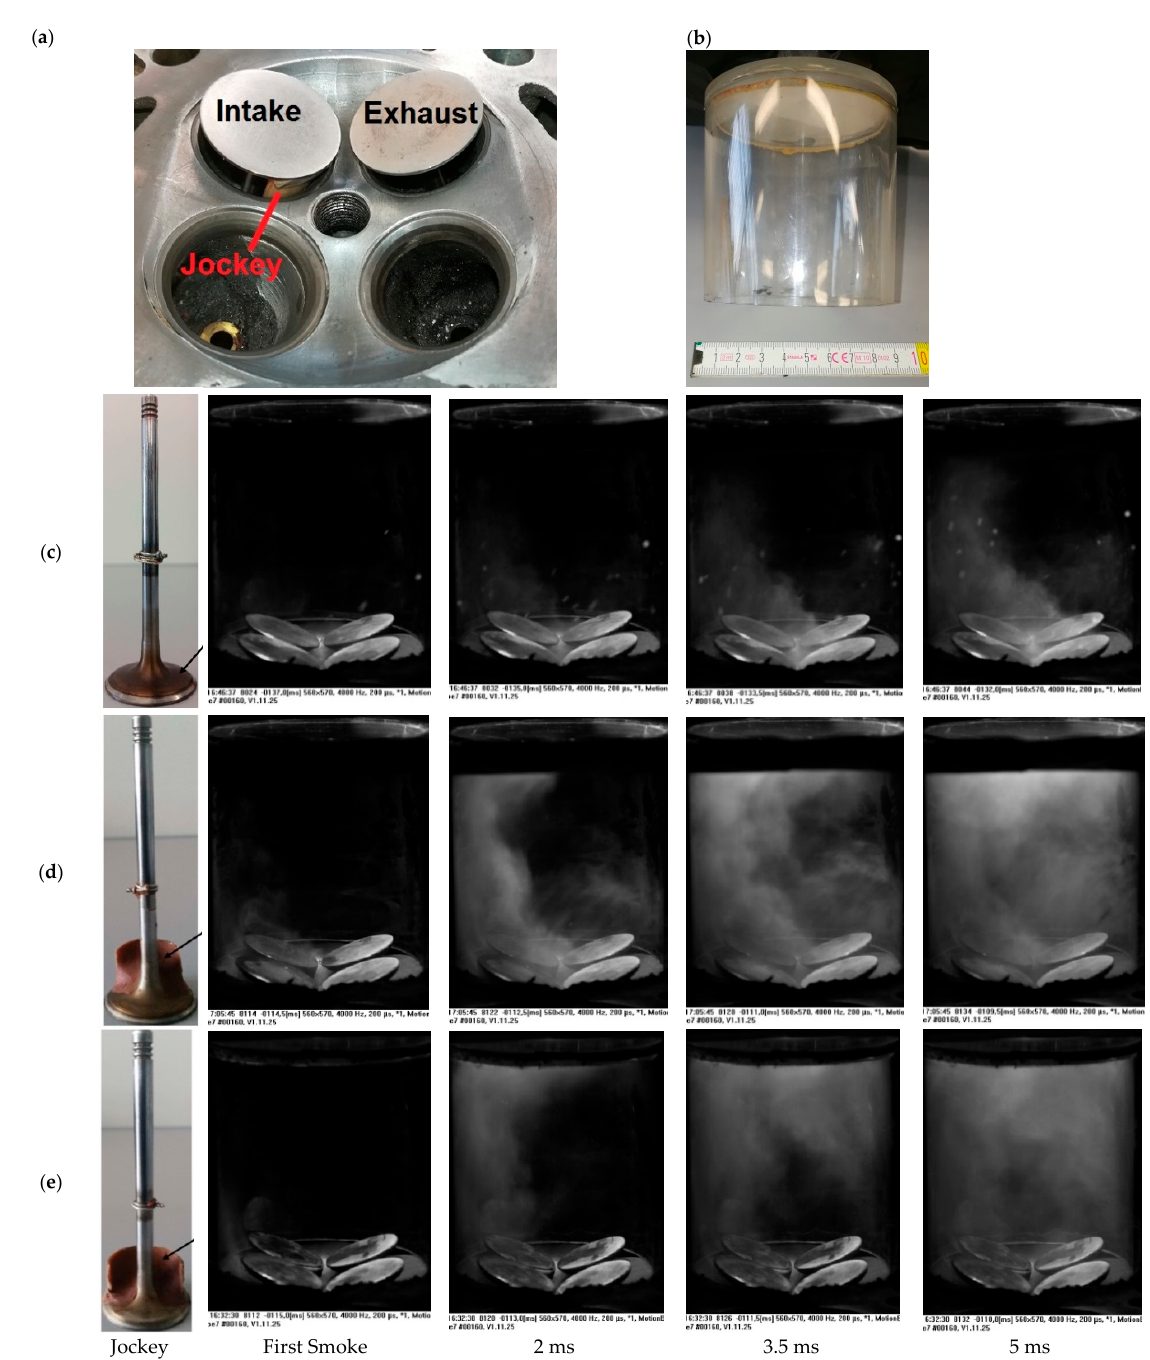
Figure 6. Flow-visualization inside a conventional 500 cm³ 4-valve cylinder (4-stroke gasoline) at 0 ms, 2 ms, 3.5 and 5 ms. ( a ) Cylinder head equipped with one outlet valve and one inlet valve with experimental jockey structure. Characteristic valve stroke is 8 mm. ( b ) Transparent perspex cylinder, scale in cm. ( c ) Unchanged and original inlet valves (left pair); poor scavenging with high loss. ( d ) α = 120° and ( e ) α = 180°. The redirected flow much better approaches cylinder volume within 5 ms. Direct shortcut into the exhaust is entirely suppressed in ( e ) and very e ff ective in ( c ). The charging occurred with 15 kPa, which is less than calculated in the simulations in Figure